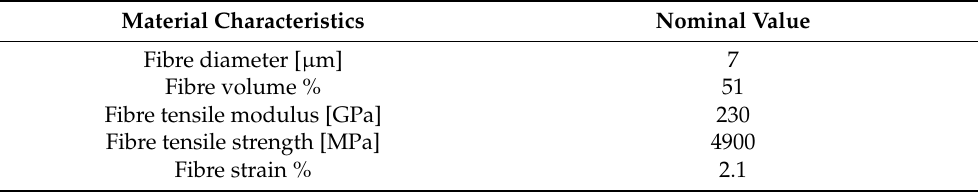
Table 1. Characteristics of CC 600 ER450 12KT700 pre-preg as reported in the datasheets [28,29]. Material Characteristics Nominal